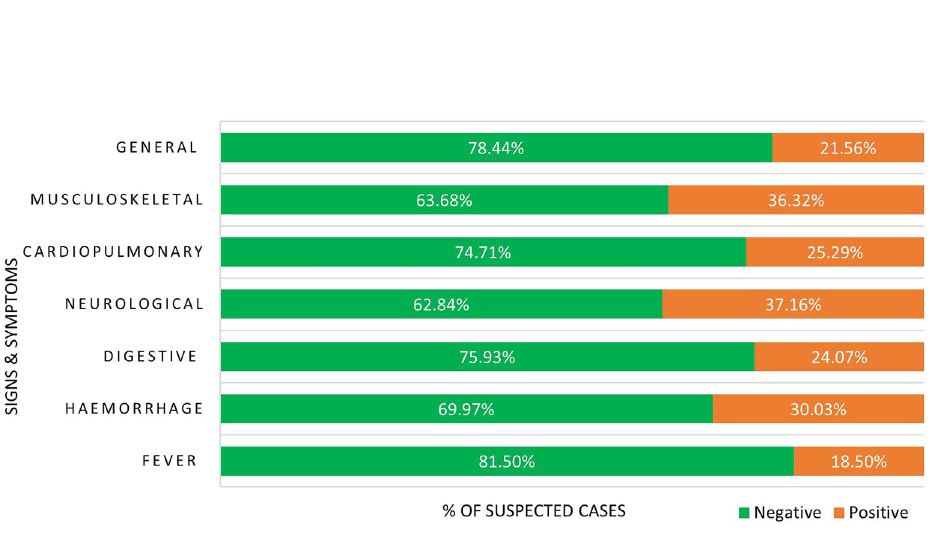
Figure 3. Lassa fever positivity status by symptoms and/or signs among suspected cases in Nigeria,